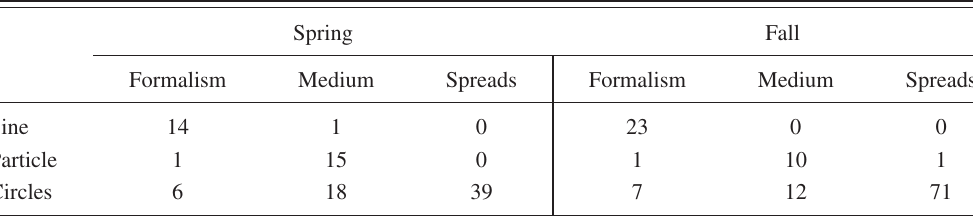
TABLE IV. Long answer reasons for sound.